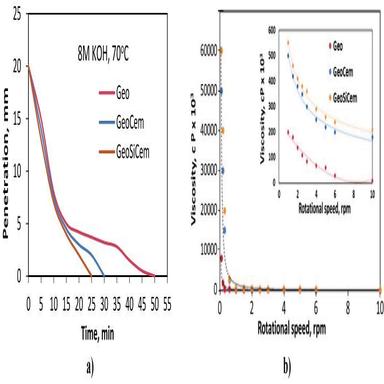
Effect of the partial Si fume substitution to cement on the a) setting time and b) viscosity of geopolymer pastes with S/L = 3.5 g/mL, 8 M KOH & 70 ◦C curing temperature.